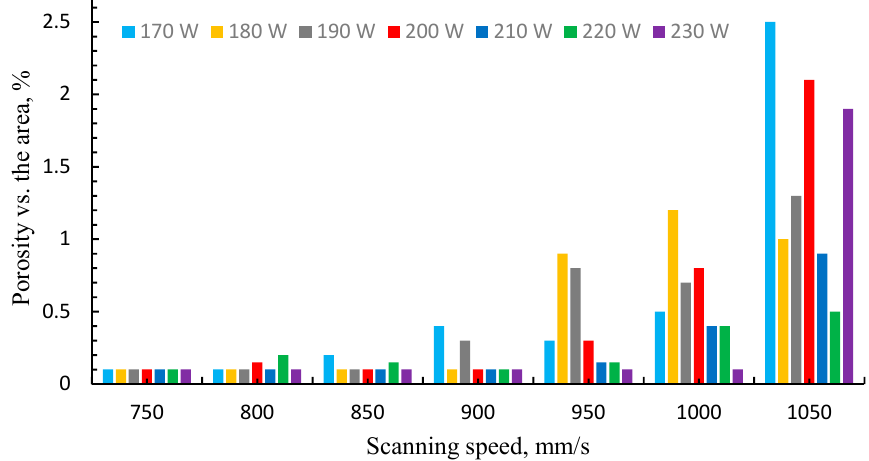
Figure 3. A histogram of porosity values depending on laser power and scanning speed.